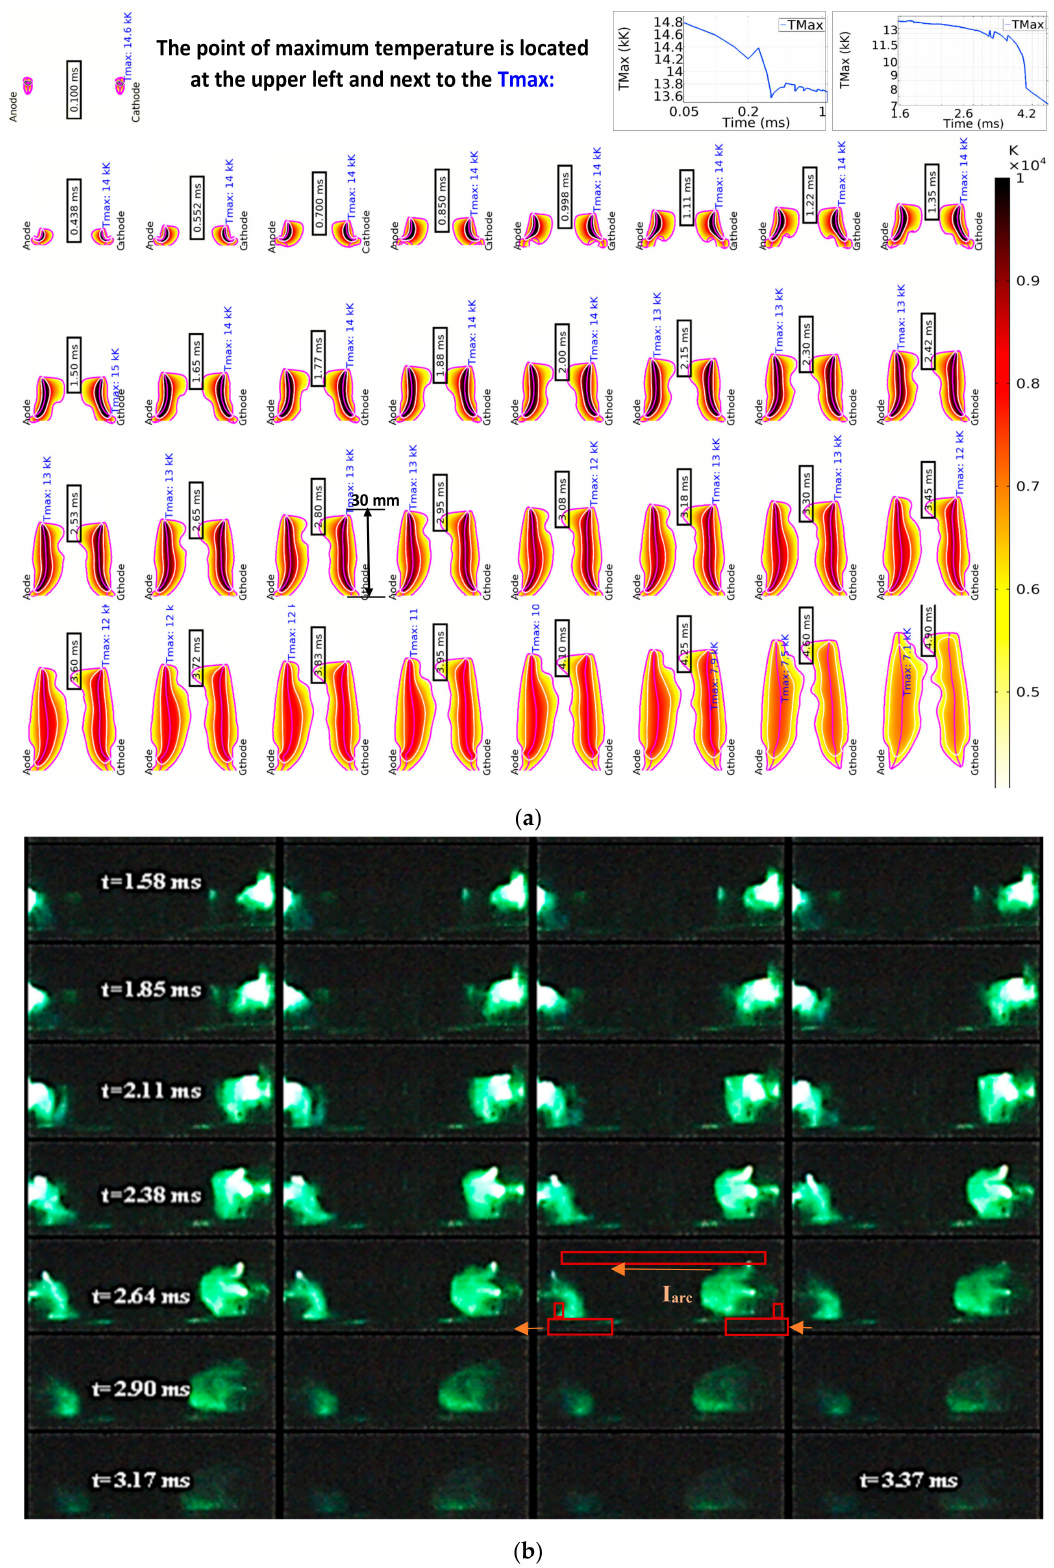
Figure 9. ( a ) Time-tagged simulated results of arc and core boundaries for two arcs in series, point of T max in 200 A peak arc, and ( b ) High-speed imaging with 15,000